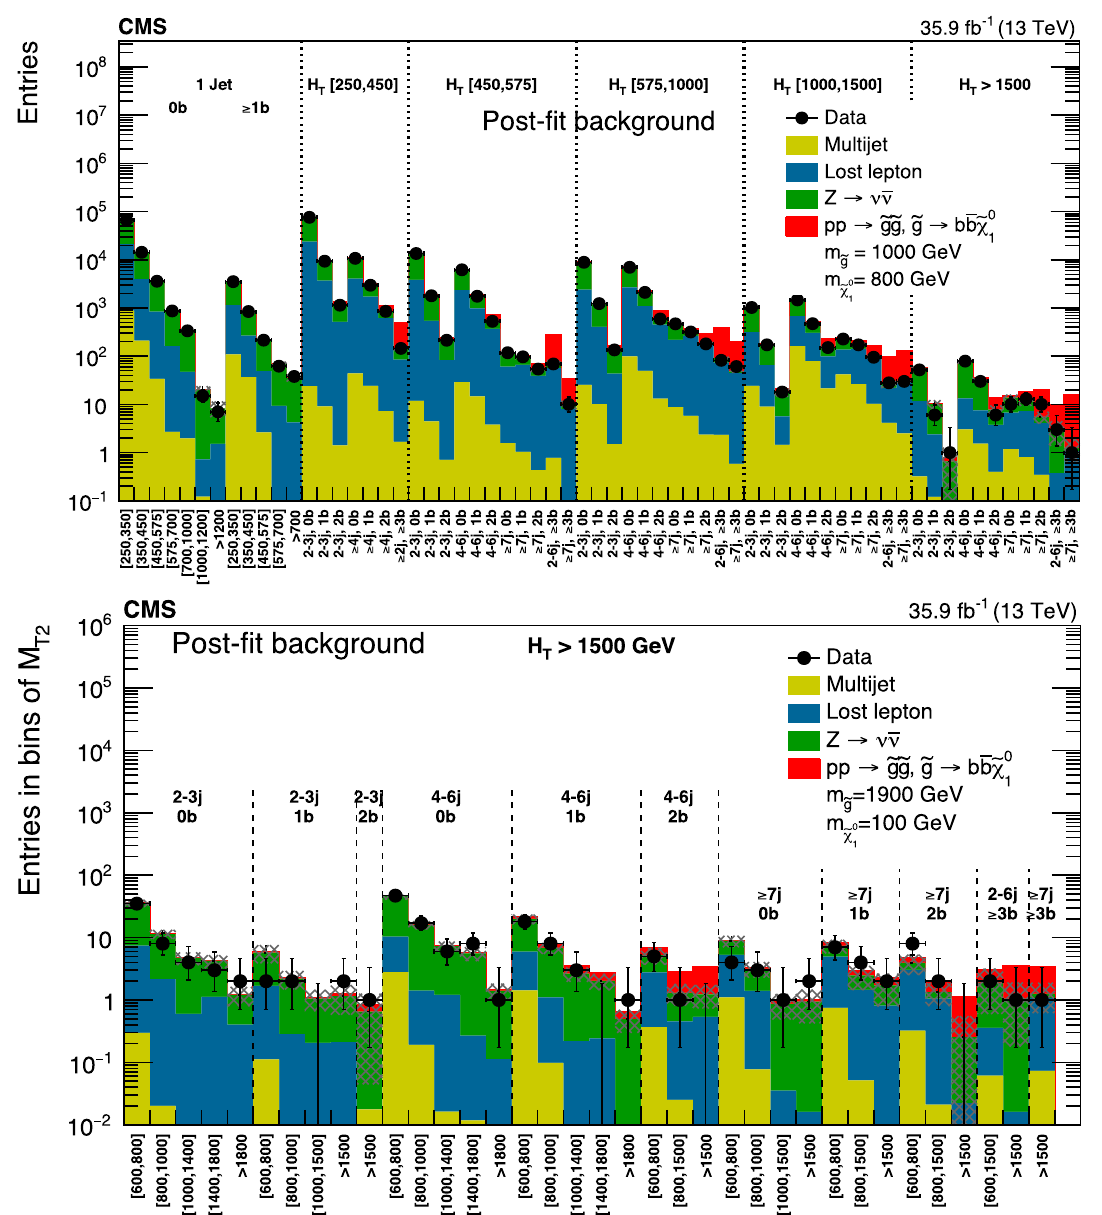
Fig. 14 (Upper) The post-fit background prediction and observed data units of GeV. (Lower) Same for the extreme- H T region for the same = 100GeV). On the x -axis, the M events in the analysis binning, for all topological regions with the signal with ( m (cid:8) g = 1900GeV, m (cid:8) χ 0 T2 1 expected yield for the signal model of gluino mediated bottom-squark binning isshown inunitsof GeV.The hatchedbands represent the post- = 800GeV) stacked on top of the production ( m (cid:8) g = 1000GeV, m (cid:8) χ 0 fituncertaintyinthebackgroundprediction.Fortheextreme- H T region, 1 the last bin is left empty for visualization expected background. For the monojet regions, the p jet1 binning is in T